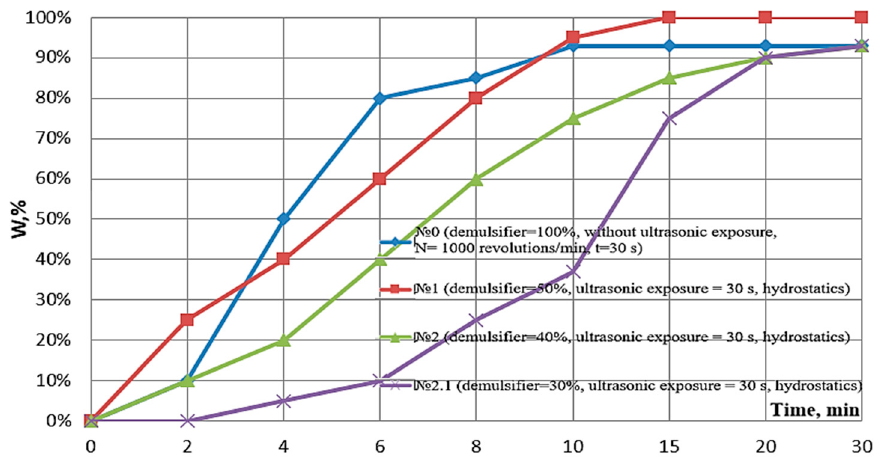
Figure 11. Dependence W (%) for modes P1 and P2 with an increase in the time of ultrasonic exposure to 30 s (W/O = 67%, T = 32 ° С ).